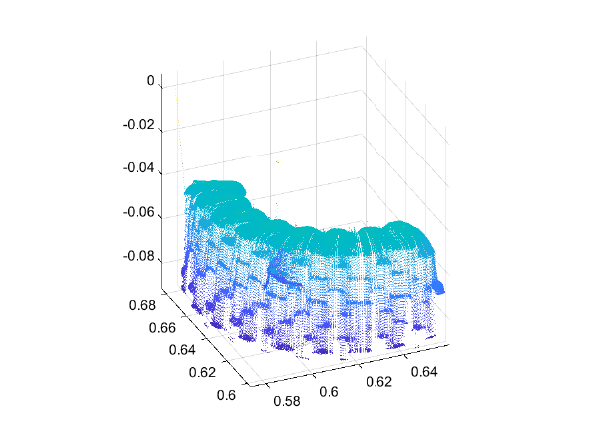
Table 2. Transformation matrix results from the scaled testing of experiment 2, comparison between ICP and marker measurement.